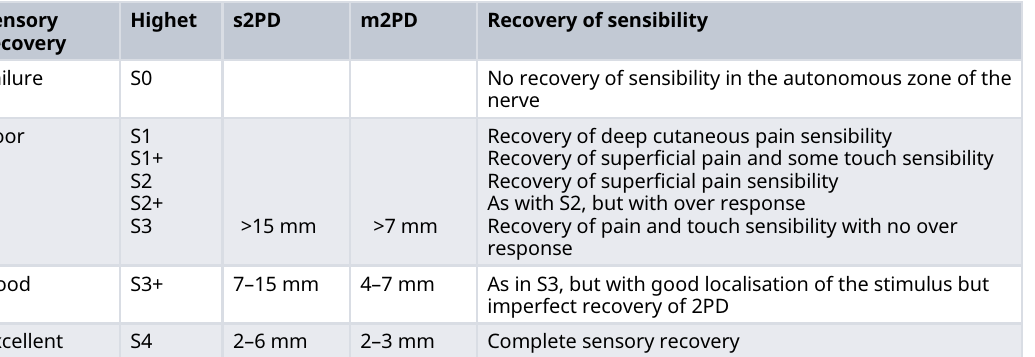
Table 2. Modified HIGHET ’ s classification (reproduced from Dunlop et al. ,